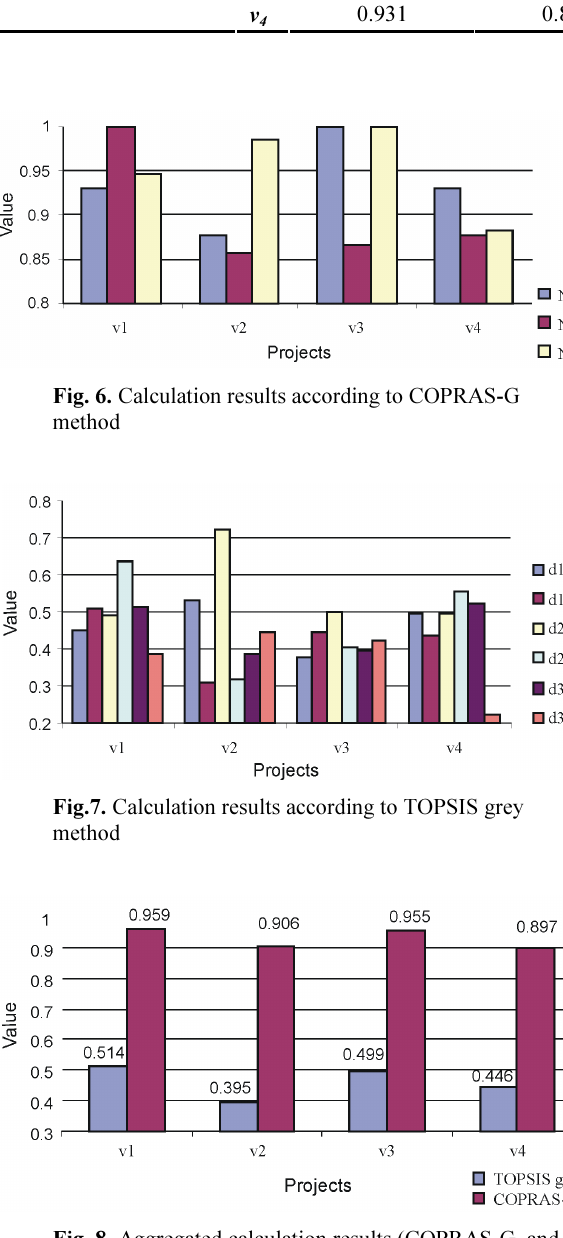
Fig. 8. Aggregated calculation results (COPRAS-G and TOPSIS grey